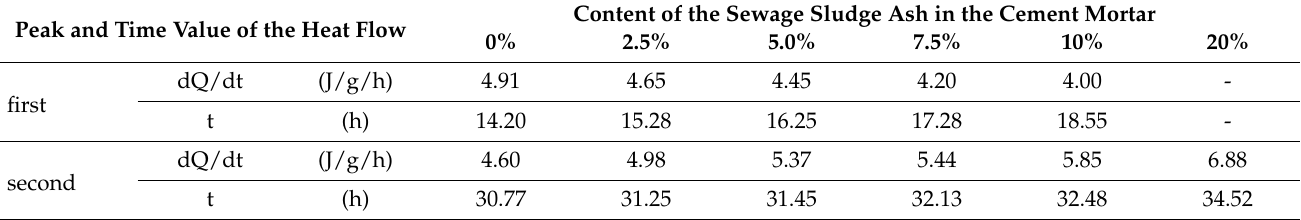
Table 5. The characteristic peak values of heat flow for cement mortars without and with SSA.